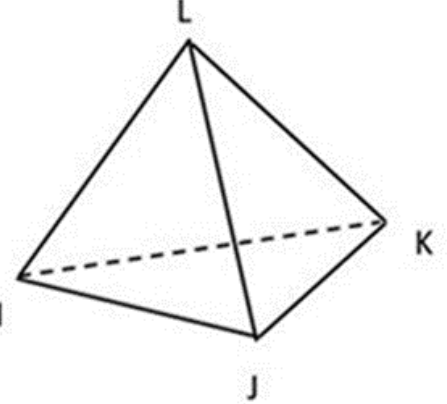
Fig. 3. Typical control volumes with uniformly distributed spherical stones.